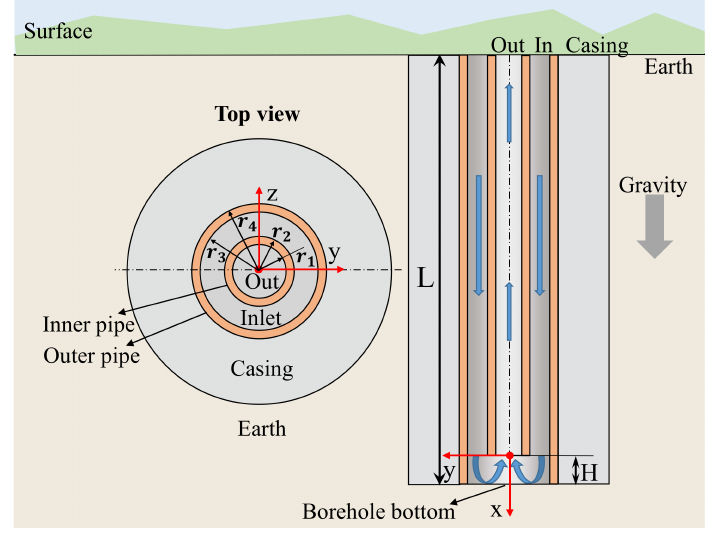
Figure 1. Schematic of the coaxial geothermal heat exchanger.